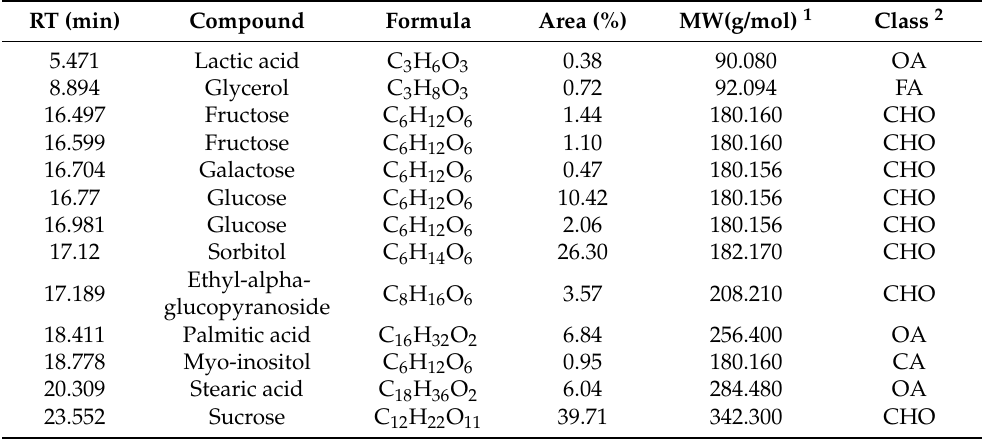
Table 4. Carbohydrate, fatty acid, organic acid, and cyclic alcohol metabolites of olive leaves extracts (OLE) identified using